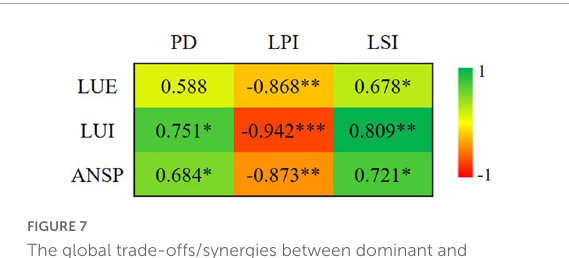
FIGURE7 The global trade-offs/synergies between dominant and recessive morphologies of land use in the NSTM. *, **, and *** denote the significance level of 0.1, 0.05, and 0.01, respectively.